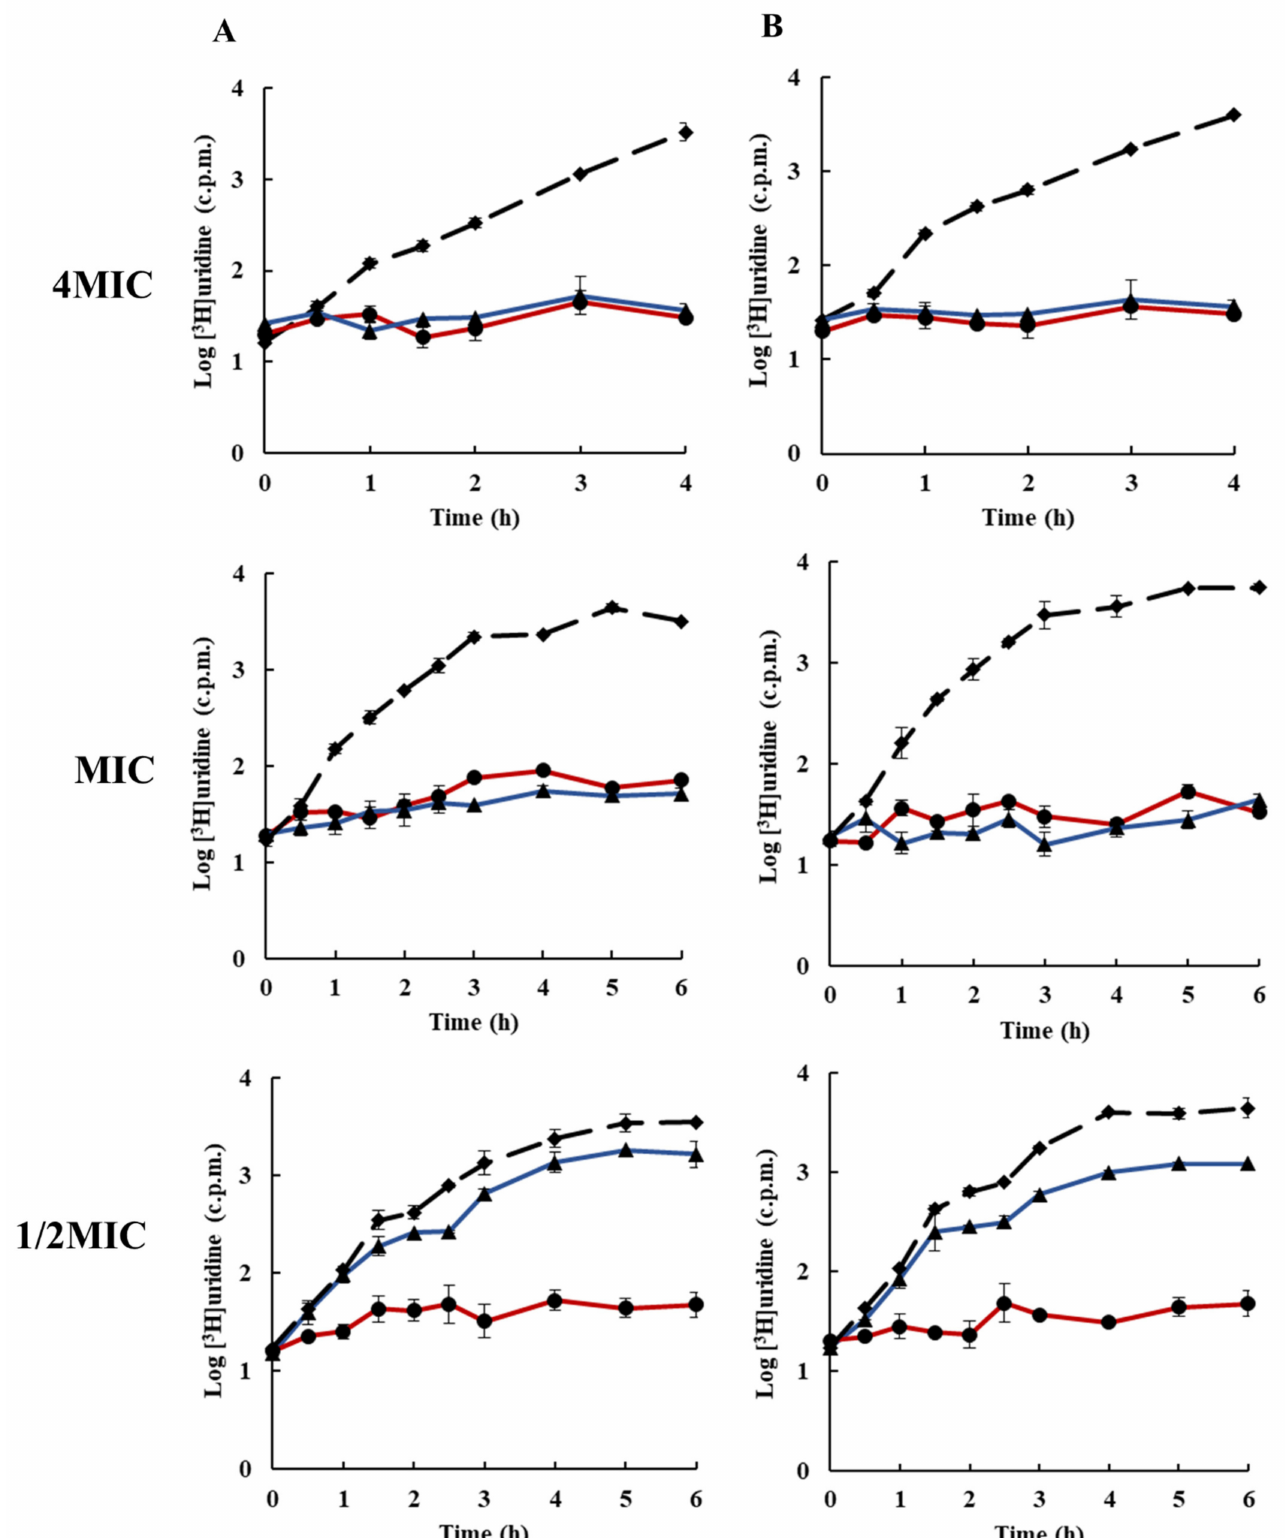
Figure 3. Effects of rhodomyrtone on RNA synthesis at 4 × MIC, MIC, and 1/2 × MIC on ( A ) EMRSA-16, ( B ) S. aureus Figure 5. Effects of rhodomyrtone on cell wall synthesis at 4× MIC, MIC, and 1/2× MIC on ( A ) EMRSA-16 and ( B ) S. aureus ATCC 29213. RNA synthesis, determined by incorporation of [ 3 H]uridine, rhodomyrtone (blue (cid:78) ),rifampicin (red • ), and ATCC 29213. Cell wall synthesis was determined by incorporation of N-acetyl-d-[1- 3 H]glucosamine. rhodomyrtone (blue ▲ ), vancomycin 1% DMSO (broken line (red ● ), and 1% DMSO (broken line  ). Each symbol indicates the mean ± SD for duplicates. ). Each symbol indicates the mean ± SD for